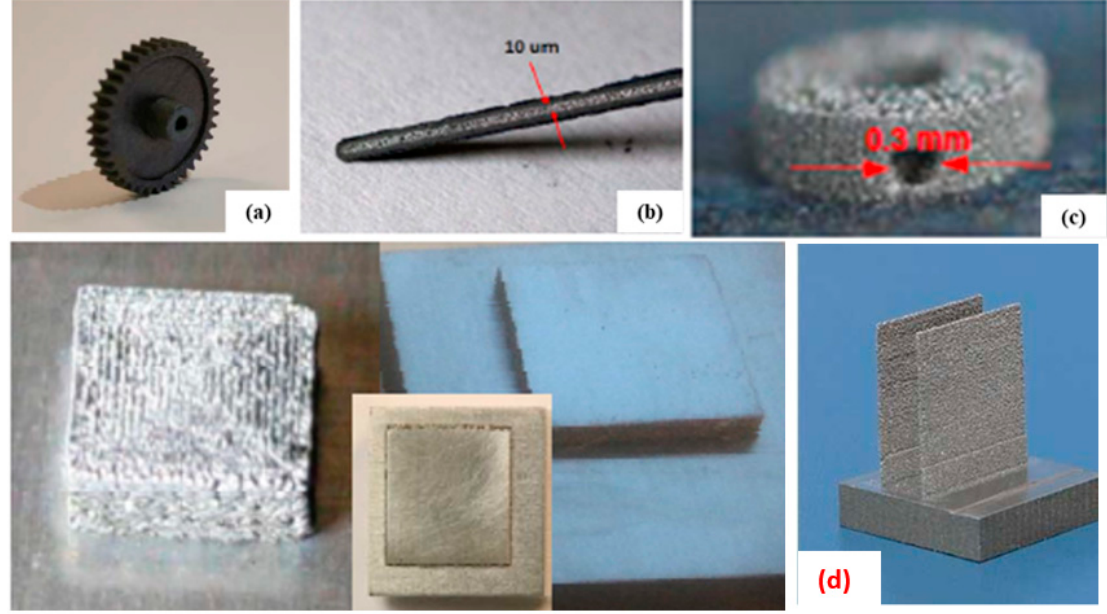
Figure 16. ( a ) A gear a half-inch in diameter 3D printed by fs laser; ( b ) fs sintered tungsten feature; ( c ) fs sintered tungsten with a small circular feature with a hole; ( d ) 3D printed thin wall of a 100 microns (Adapted from reference [44]).